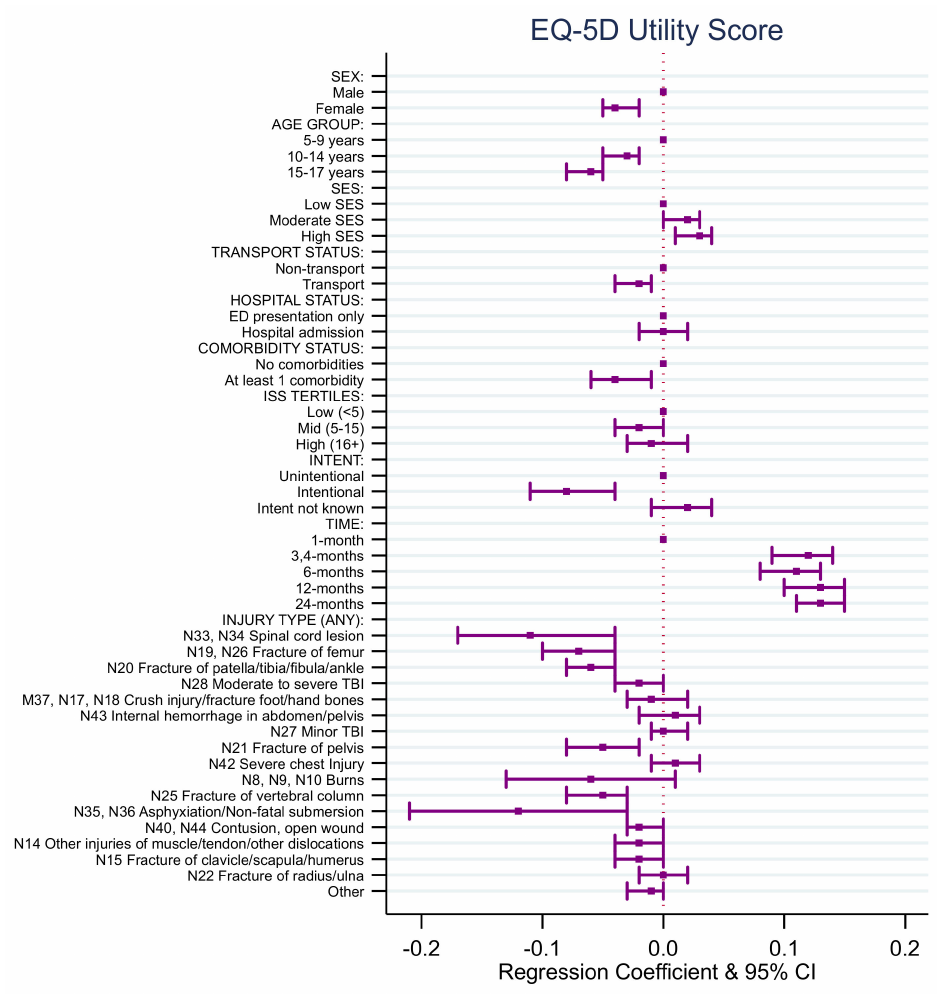
Figure 3. EQ-5D utility score regression